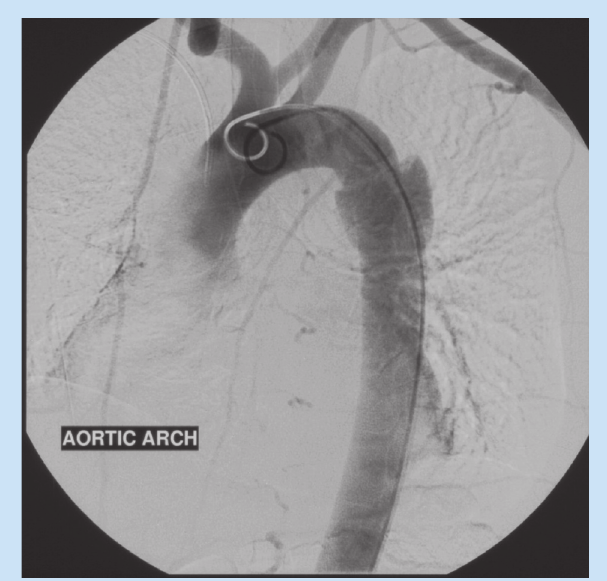
Fig. 3. Digital subtraction angiogram with the pigtail catheter in the aortic arch demonstrating the descending thoracic aortic pseudo-aneurysm distal to the origin of the